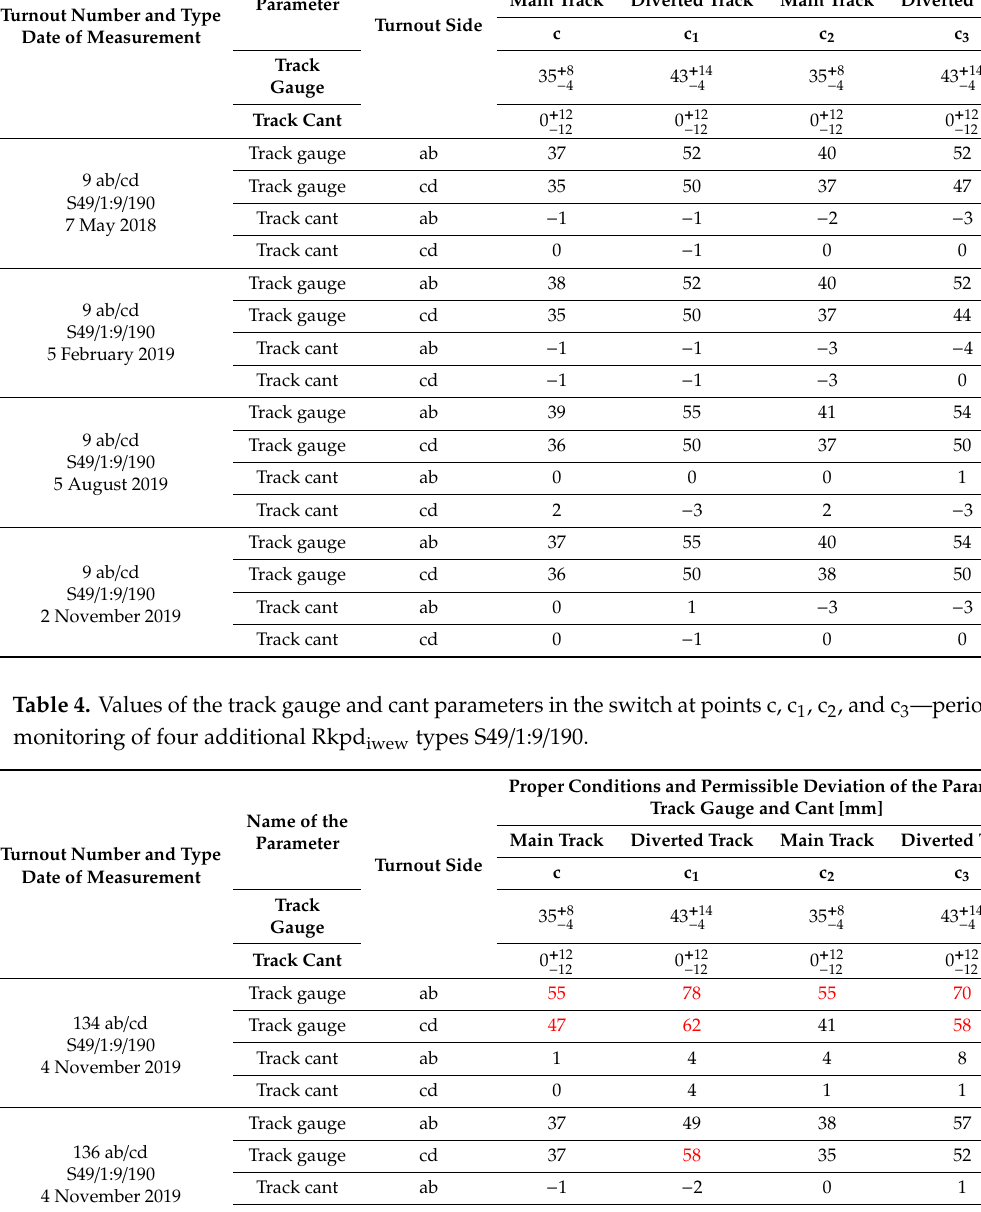
Table 3. Values of the track gauge and cant parameter of the switch for points c, c 1 , c 2 , and c 3 —periodic monitoring of Rkpd iwew No. 9 type S49 / 1:9 / 190.